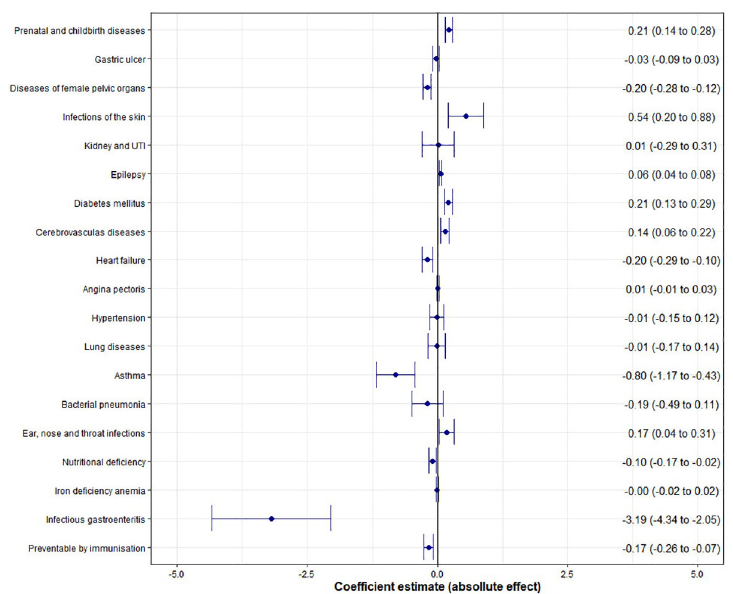
Fig 5. Effect of the FHS on preventable hospitalizations by disease class. Infectious gastroenteritis. Source: SIH; CNES/DATASUS.